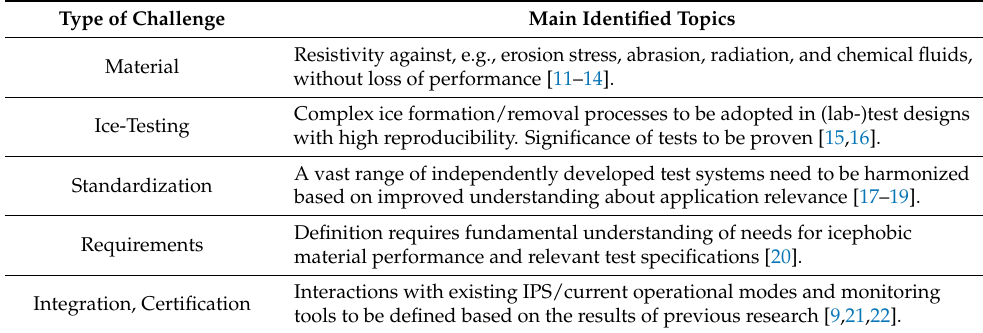
Table 1. Challenges associated with the use of icephobic materials for technical applications.